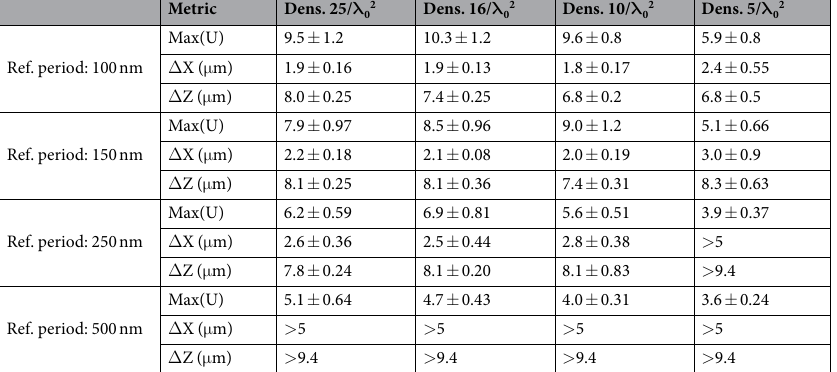
Metric Dens. 25/ λ 02 Dens. 16/ λ 02 Dens. 10/ λ 02 Dens. 5/ λ 02